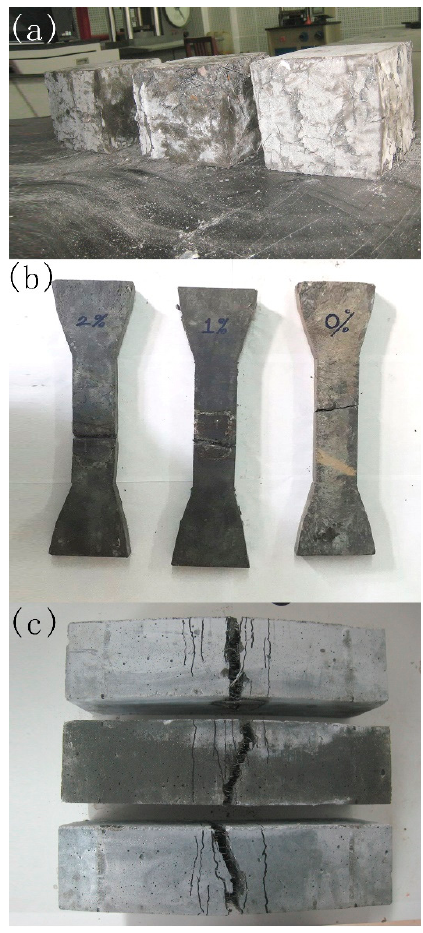
Figure 4. Failure model; ( a ) compression; ( b ) tension; and ( c ) flexure.